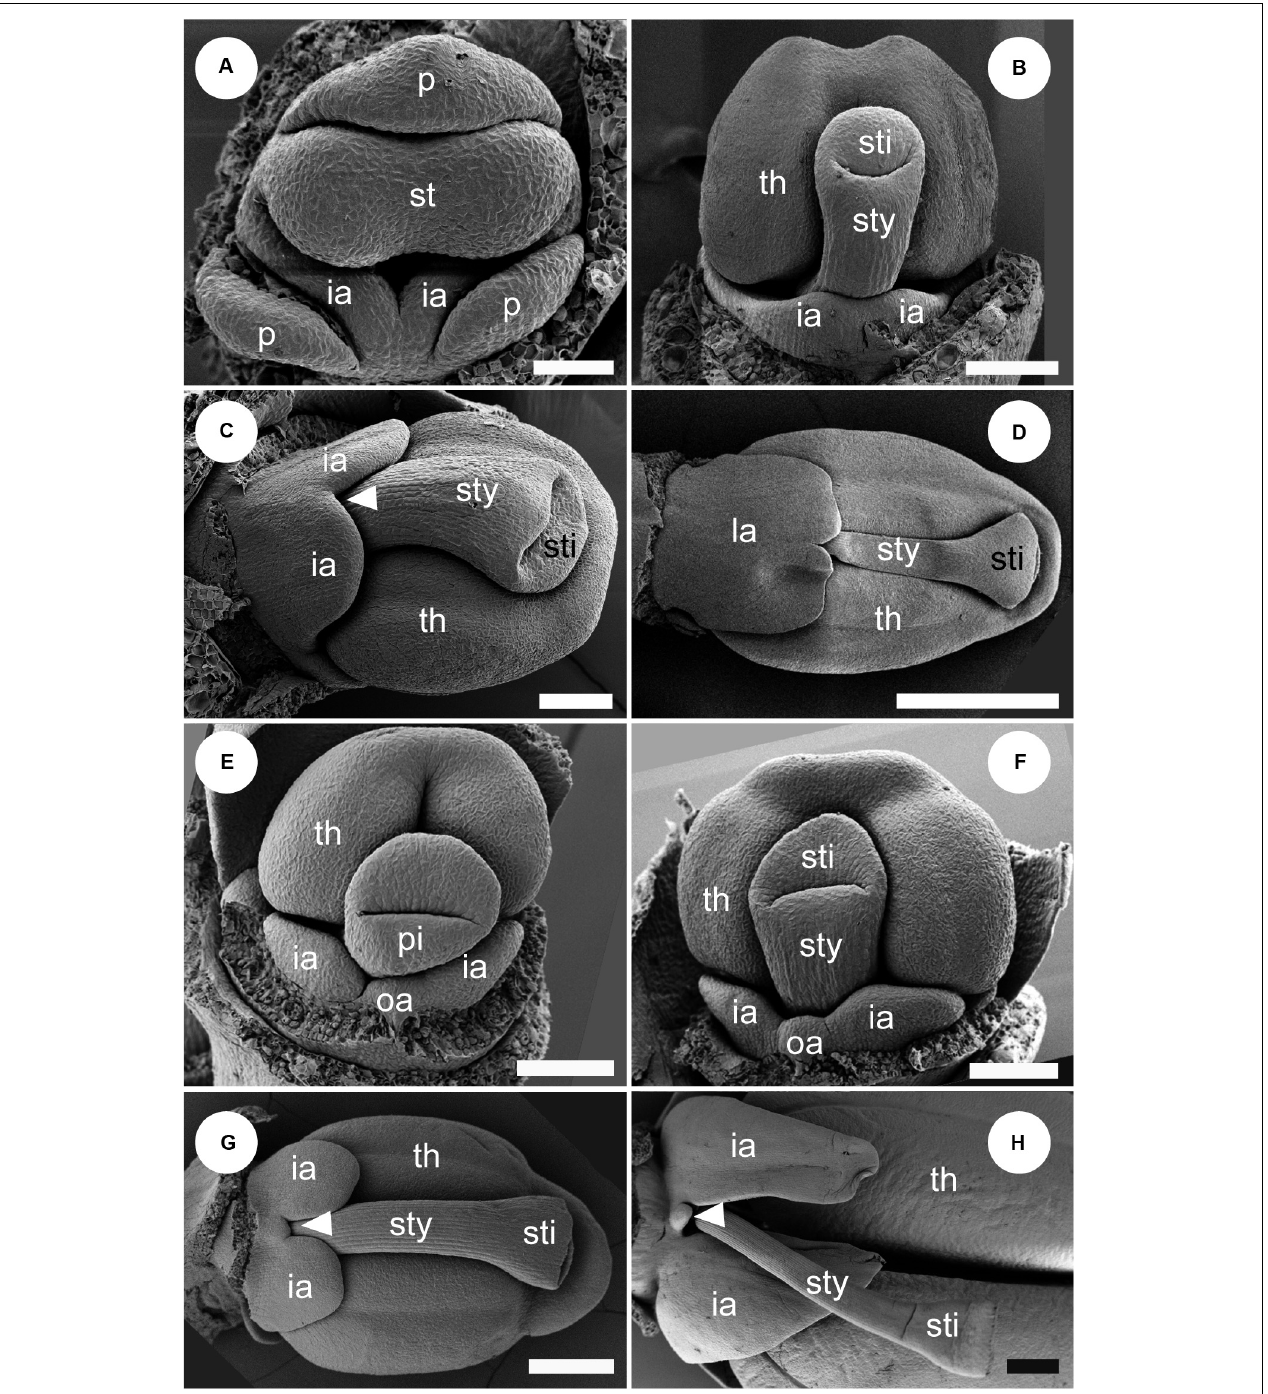
FIGURE 11 | Labellum development of Globba. Sepals are removed in panel (A), and both sepals and petal are removed in panels (B–H) . (A–D) Labellum development of Globba paniculata. (A) Two inner androecial primordia (ia) are initiated, and an outer abaxial androecial primordium (oa) is not observed. (B) The two inner abaxial staminodes develop as a broad bilobed primordium. (C) The limit between the two staminodes becomes clear as an apical notch (arrowhead). (D) The labellum grows upward and progressively covers the abaxial side of the stamen; the tip of the labellum is depressed. (E–H) Labellum development of G. geoffrayi. (E,F) Two inner androecial primordia and an outer abaxial primordium are initiated. (G,H) Two inner androecial primordia develop and an outer abaxial primordium is small, although it clearly exists. ia, inner androecial primordium; oa, outer androecial primordium; p, petal primordium; st, stamen primordium; sty, style; th, thecae. Scale bars = (A) 50 µ m, (B,C,E,F) 100 µ m, (D,G,H) 500 µ m.